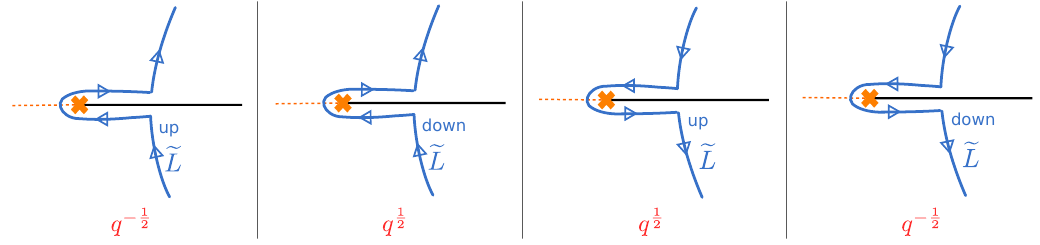
Figure 18 . Detour factors contributing to the overall weight (cid:11) ( e L ). Notation is as in (cid:12)gure 17 above.